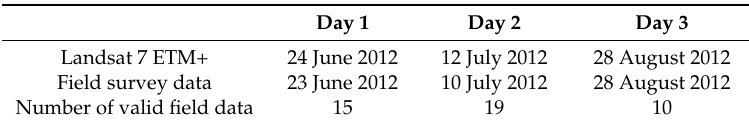
Table 1. Dates of the Landsat 7 ETM+ data acquisition, field FVC measurements, and number of valid field FVC measurements.